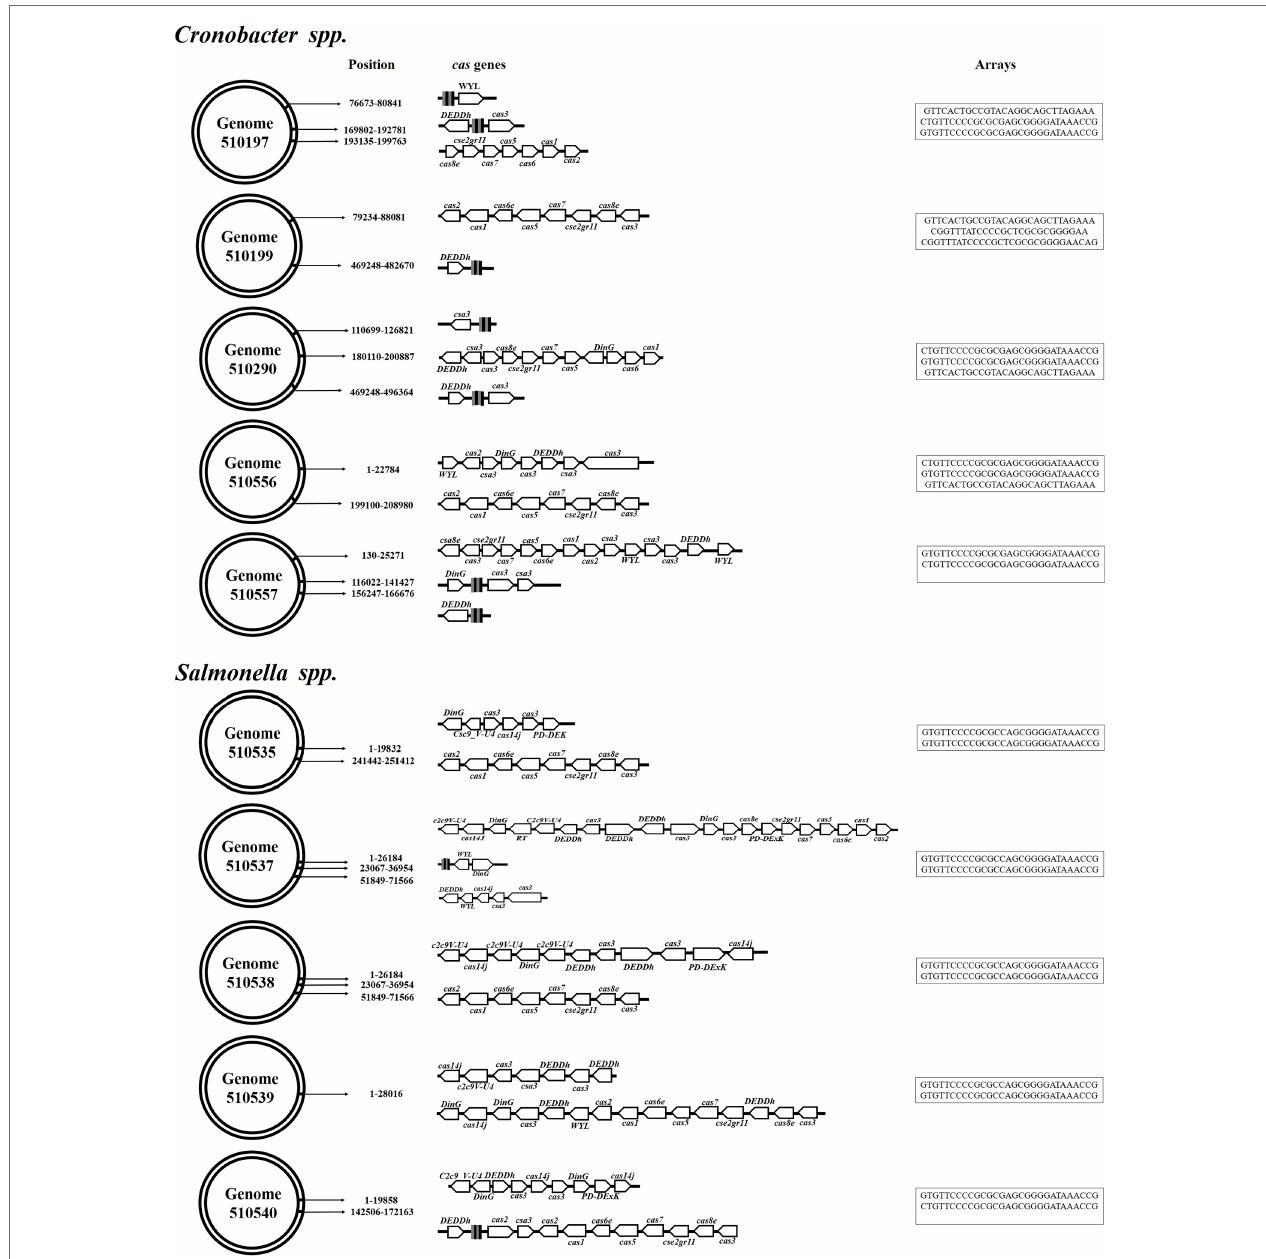
FIGURE 3 | CRISPR-Cas systems identified in Cronobacter spp. and Salmonella spp. genomes. The identified systems belong to the I-E and I-F CRISPR-Cas